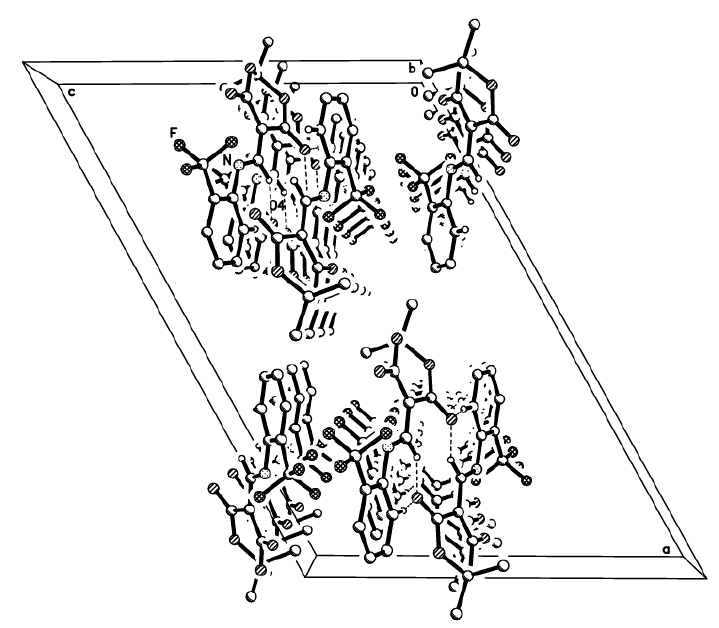
Figure 2. Crystal packing of 3 viewed along [010] with the H-bonding pattern as dashed lines. Hydrogen atoms not involved are omitted.